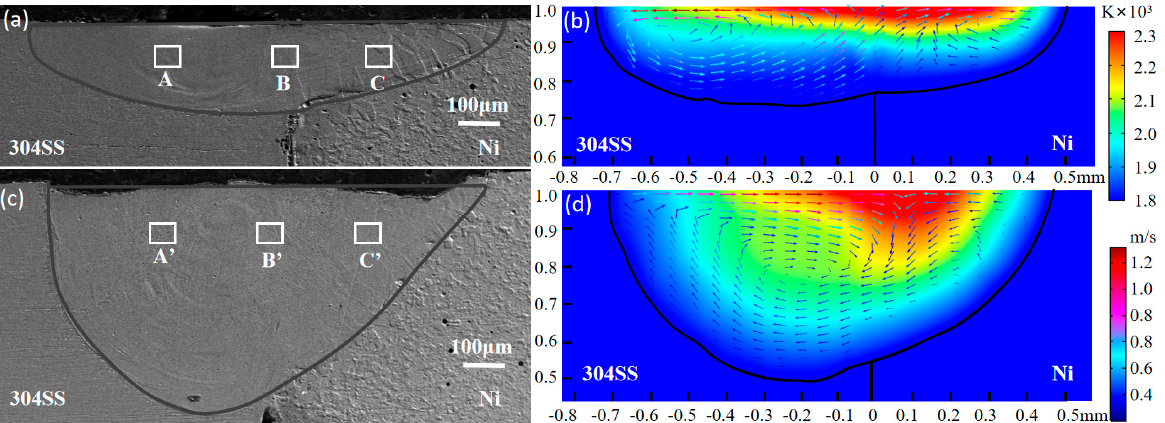
Figure 4. Cross–sectional morphology of molten pool. ( a ) Experimental morphology in pure argon; ( b ) simulative molten pool in pure argon; ( c ) experimental morphology in the AMO; and ( d ) simulative molten pool in the AMO.